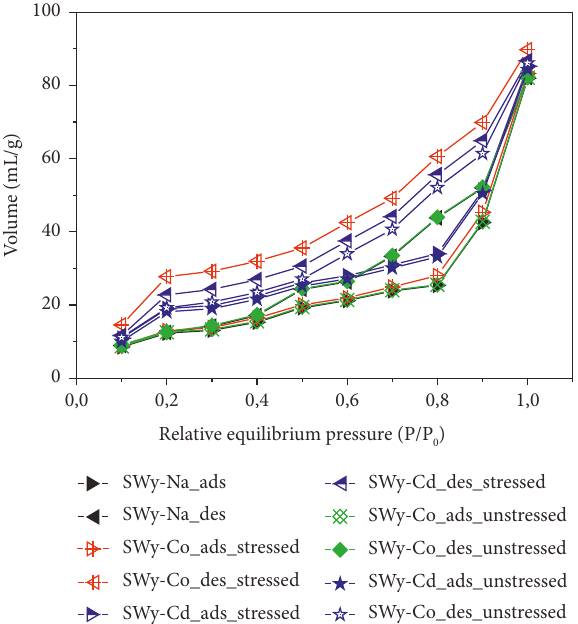
Figure 8: Nitrogen adsorption- (ads-) desorption (des) isotherms. Table 4: The basic physical approximations adopted for the PSD